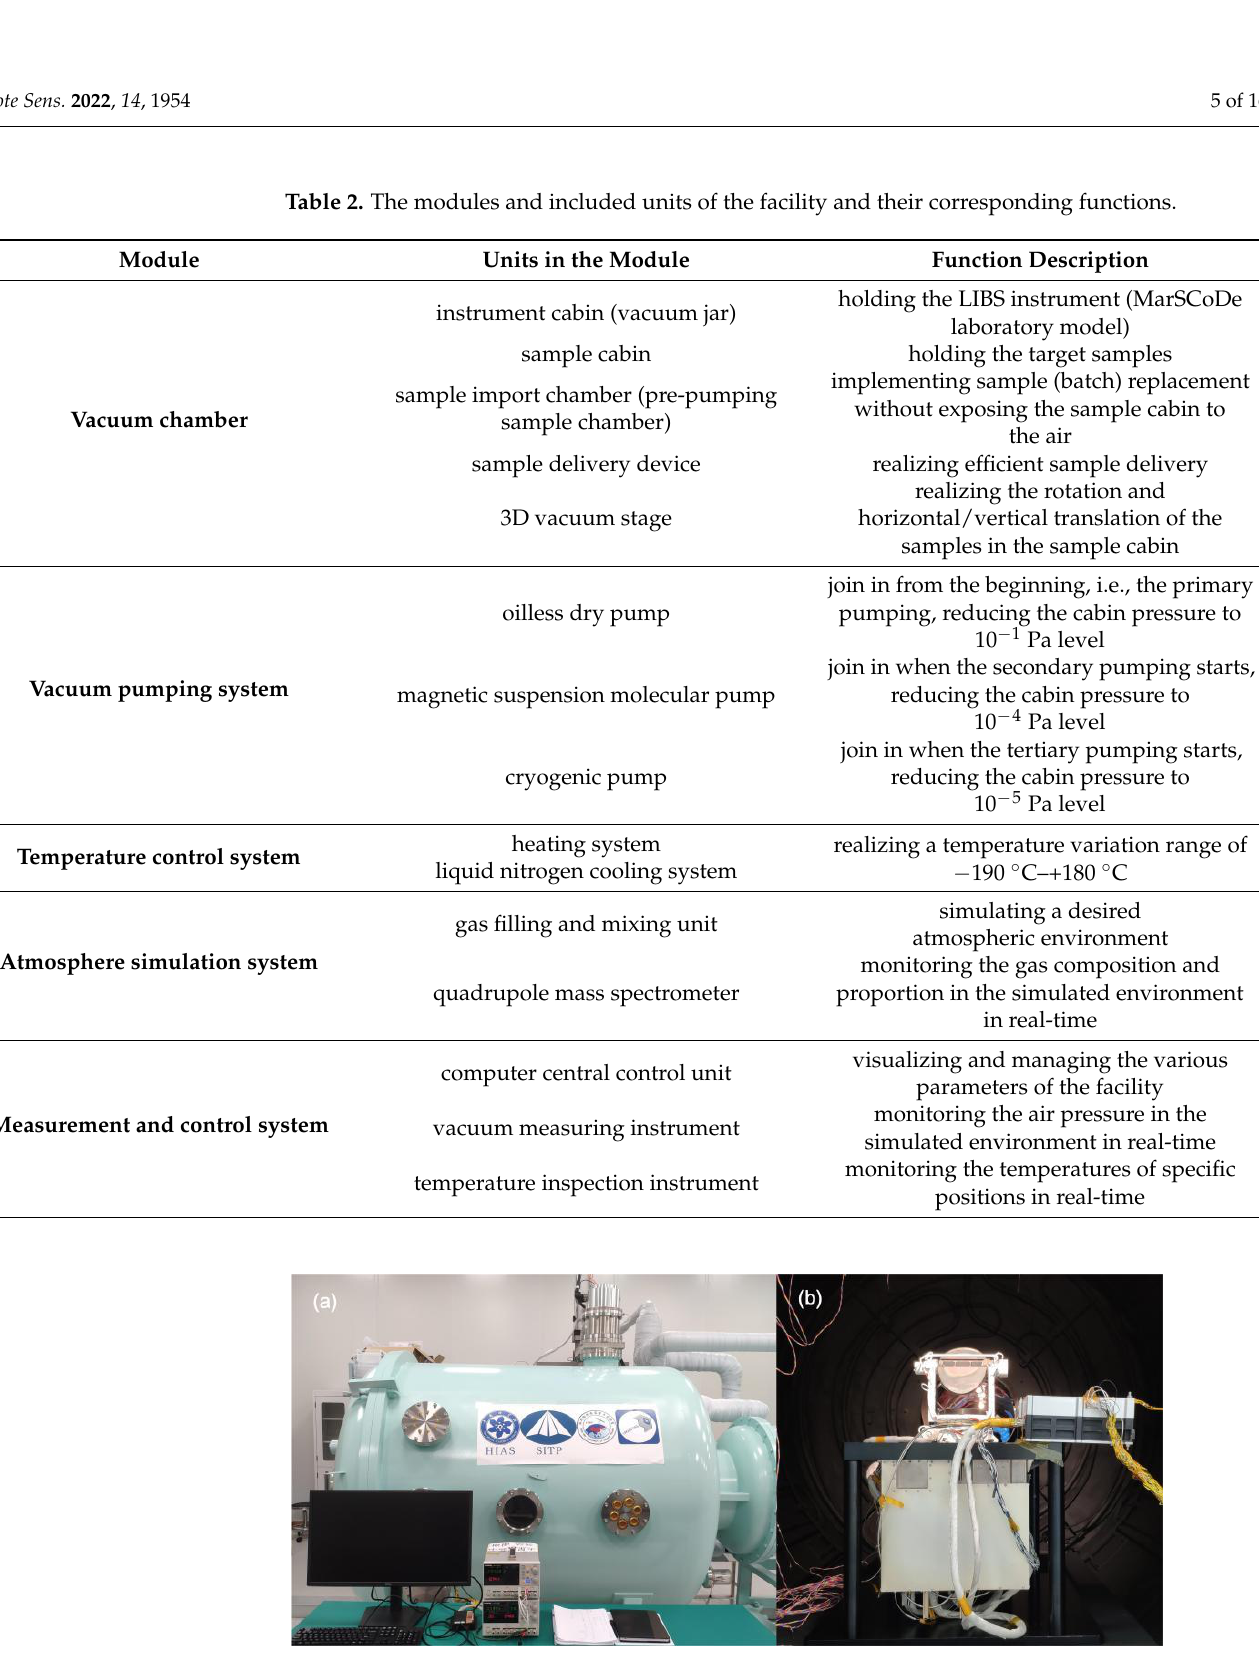
Figure 3. ( a ) Appearance of the instrument cabin. ( b ) Photograph of the MarSCoDe laboratory model inside the instrument cabin.